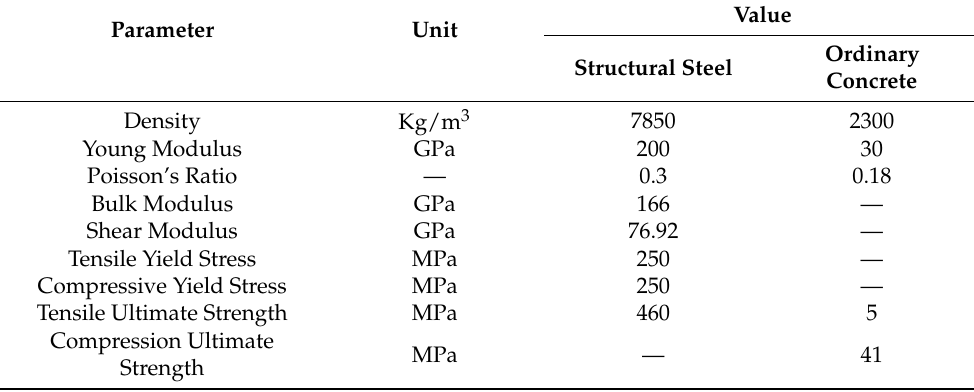
Table 2. Mechanical characteristics of the materials used in the current study [37,39].